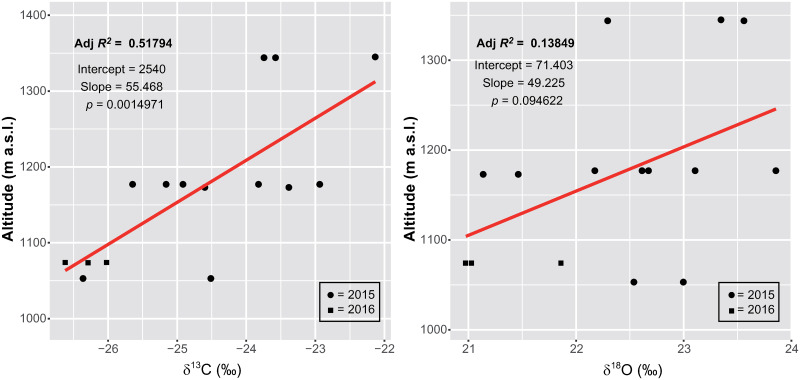
300 m altitudinal transect of Picea abies at Tatrzański Park Narodowy.The plots show the linear regression analysis of δ13Cpollen values and altitude (left) and δ18Opollen values and altitude (right). Samples were taken in 2015 (black dots) and 2016 (black squares). The red line indicates the slope of the linear regression model. Adjusted R2 indicates the proportion of variance explained by the linear association of isotopes and elevation.